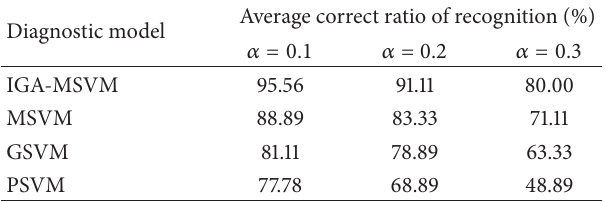
Table 5: Comparison of the noise immunity by using four different models for fault